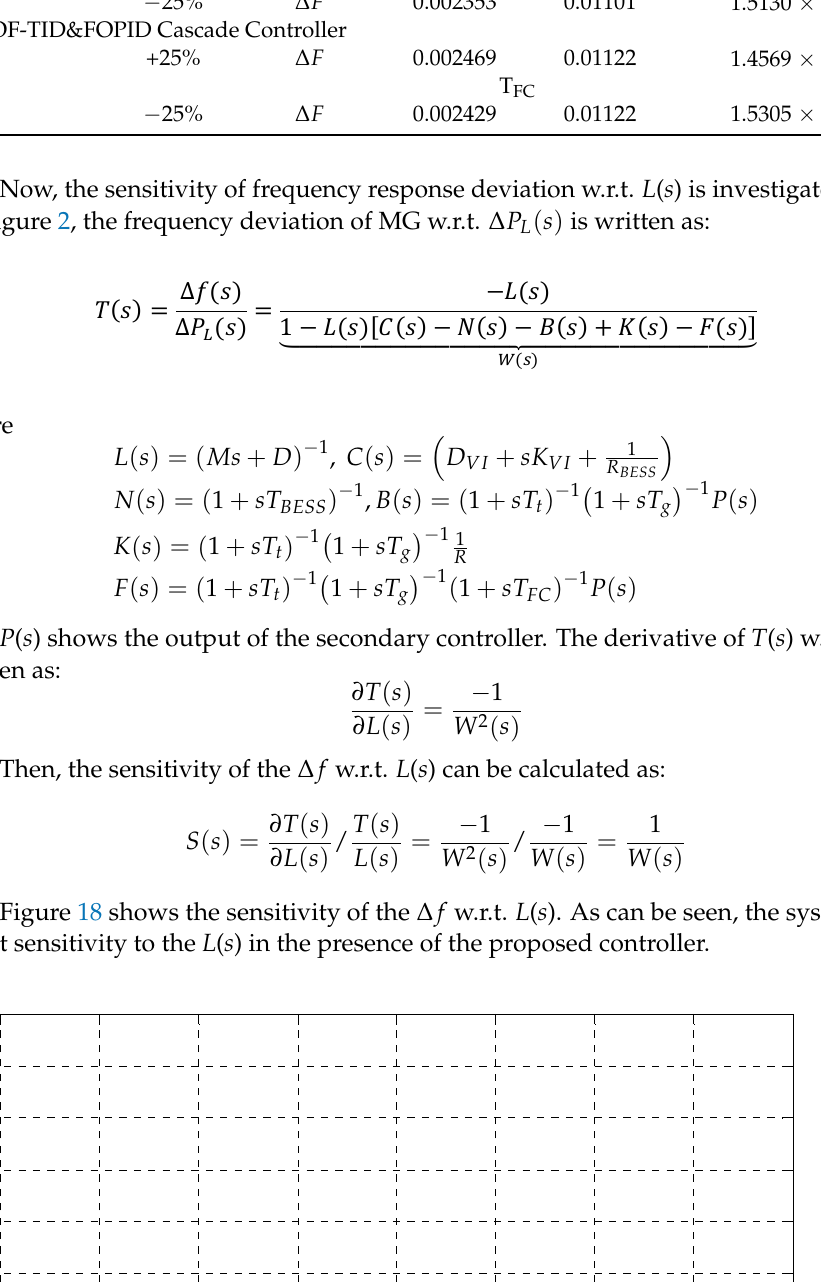
Figure 18. Frequency deviation sensitivity w.r.t. L ( s ) by employing the proposed controller.